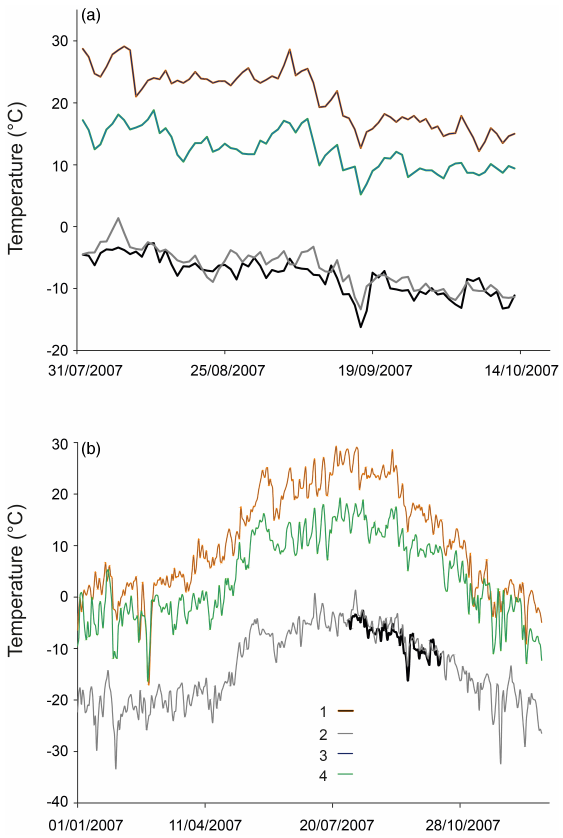
Figure 3. Daily temperature means ( T , ◦ C) for the periods of